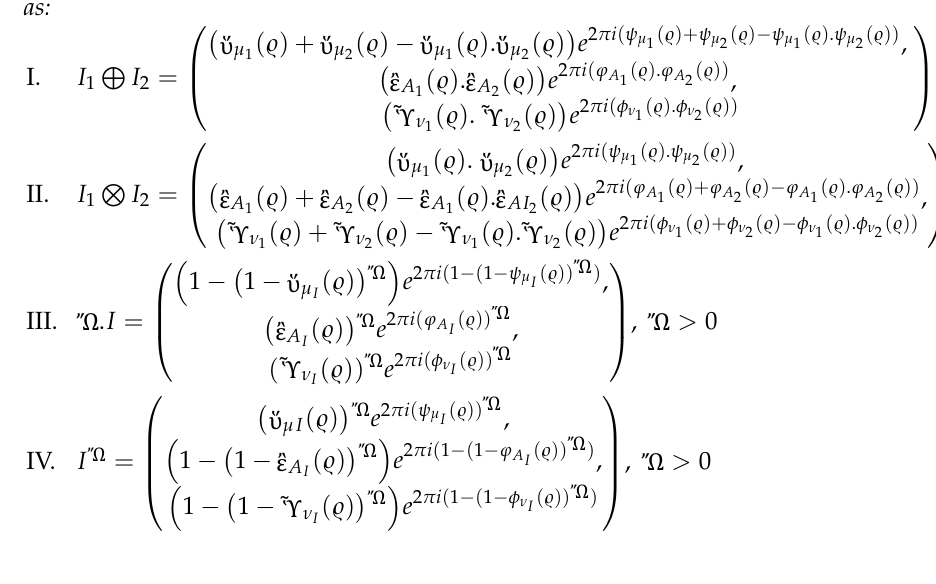
Table 1. Symbols and their